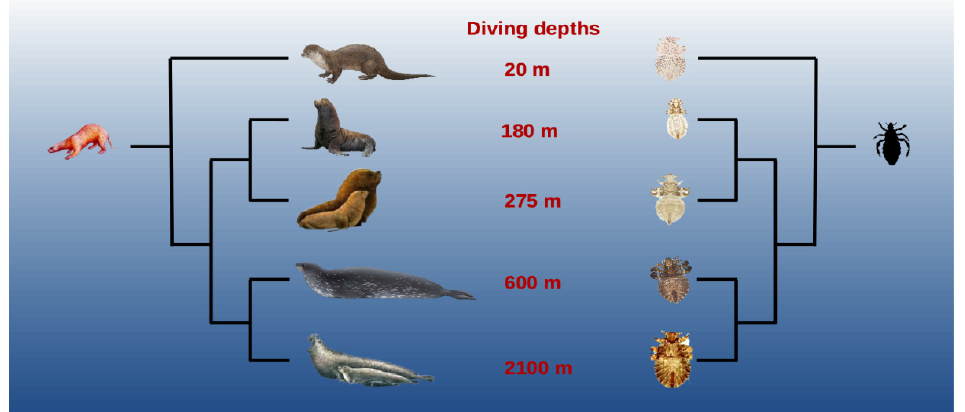
Figure 1. Schematic phylogenetic tree comparing the evolutionary histories of pinnipeds ( left ) and their lice ( right ), modified from Leonardi et al. (2019). Host-louse associations: 1—North American